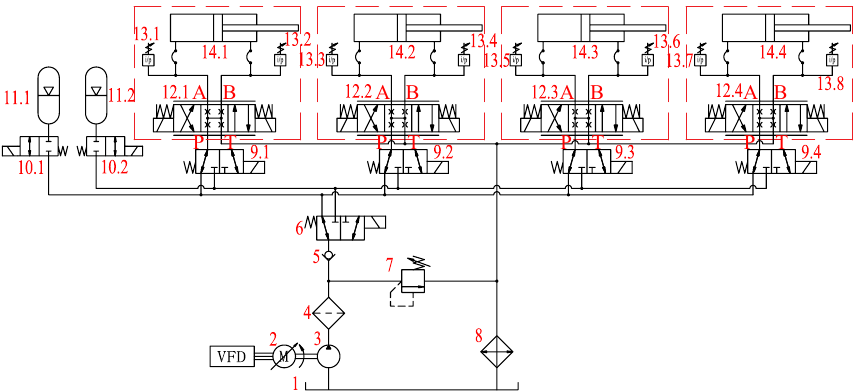
Figure 2. Principle of hydraulic system.